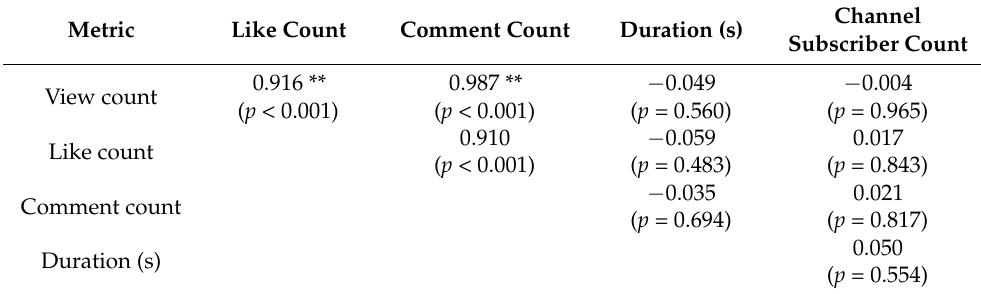
Table 2. Pearson correlation between video